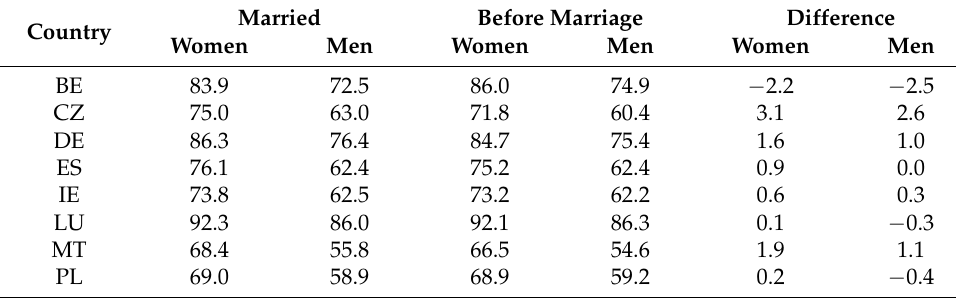
Table 5. The average NRR before and after marriage. Married Before Marriage Country